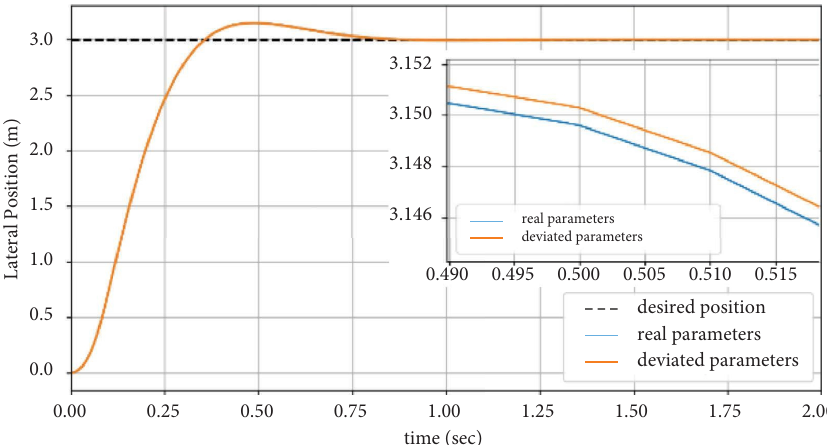
Figure 7: Tracking desired lateral position in the presence of uncertainties in the model parameters.